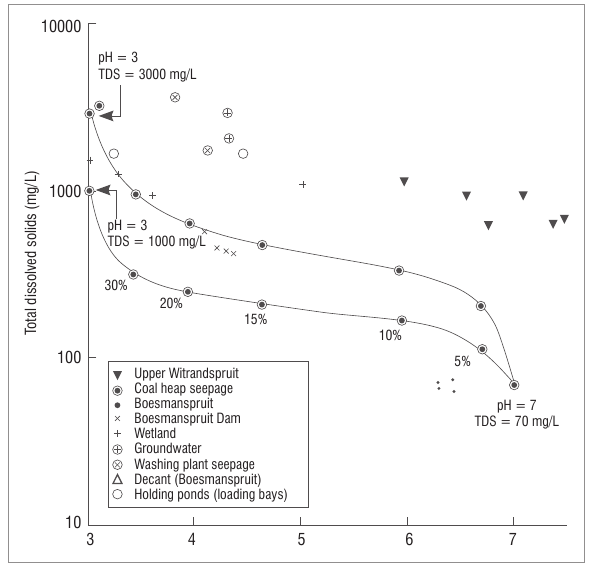
Figure 15: Plot of pH against total dissolved solids (TDS) showing water samples from the Boesmanspruit catchment and model curves formed by mixing unpolluted, buffered water and water with a pH=3 and TDS=1000 mg/L and water with a pH=3 and TDS=3000